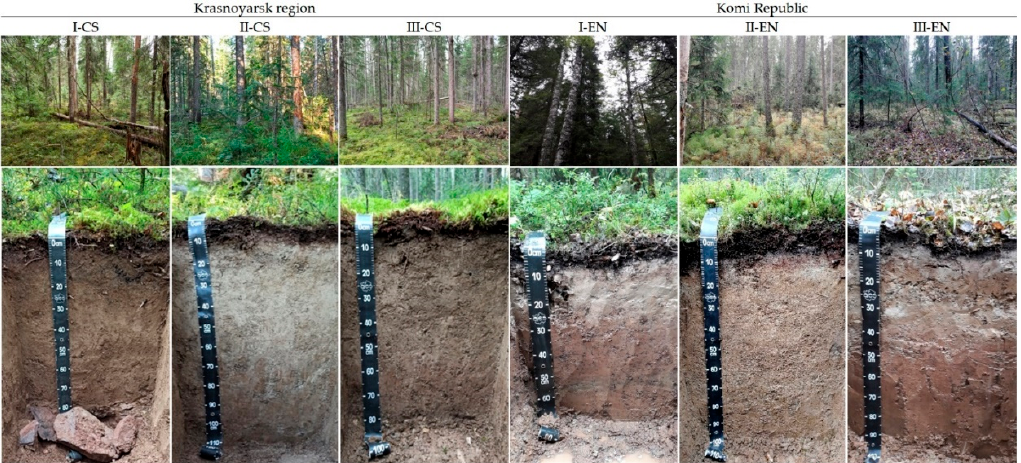
Figure A1. Photos of forests and soil profiles. EN—European North (Komi Republic); CS—Central Siberia (Krasnoyarsk region); I, II, III—site numbers. Table A1. Texture of the studied soils.